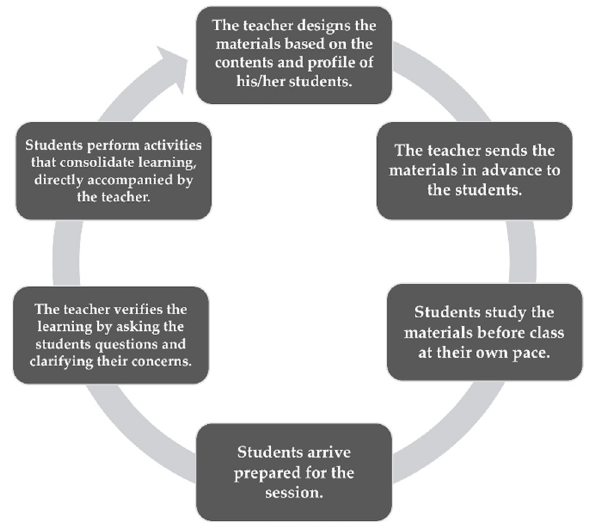
Figure 1. The teaching process in the Flipped Classroom model.